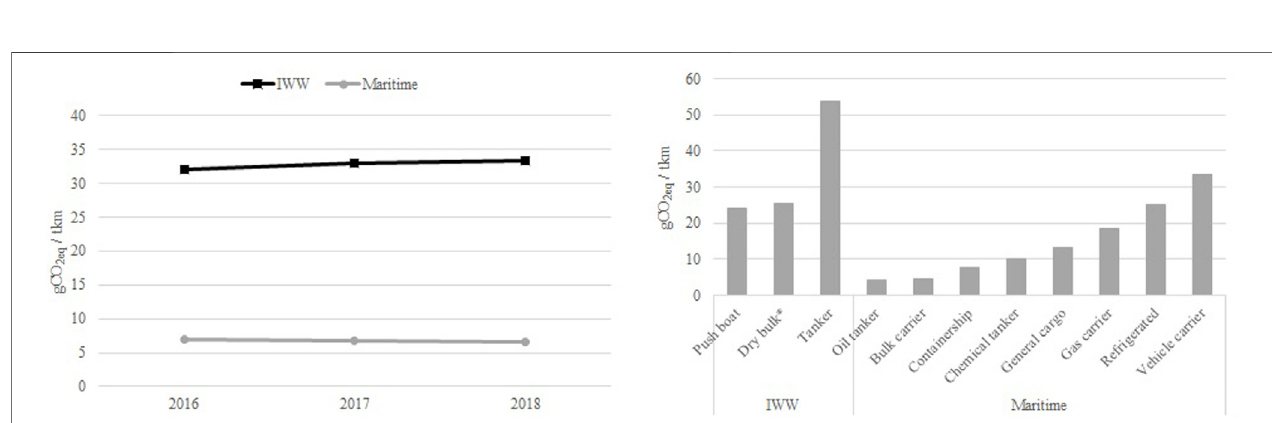
FIGURE2| WTWGHGemissionlevelsbytypeofvessel(left)andbyvesselpurposein2019(right).Note:*meansthatcontainerisincluded.Source:adaptedfrom data in EEA (2020).